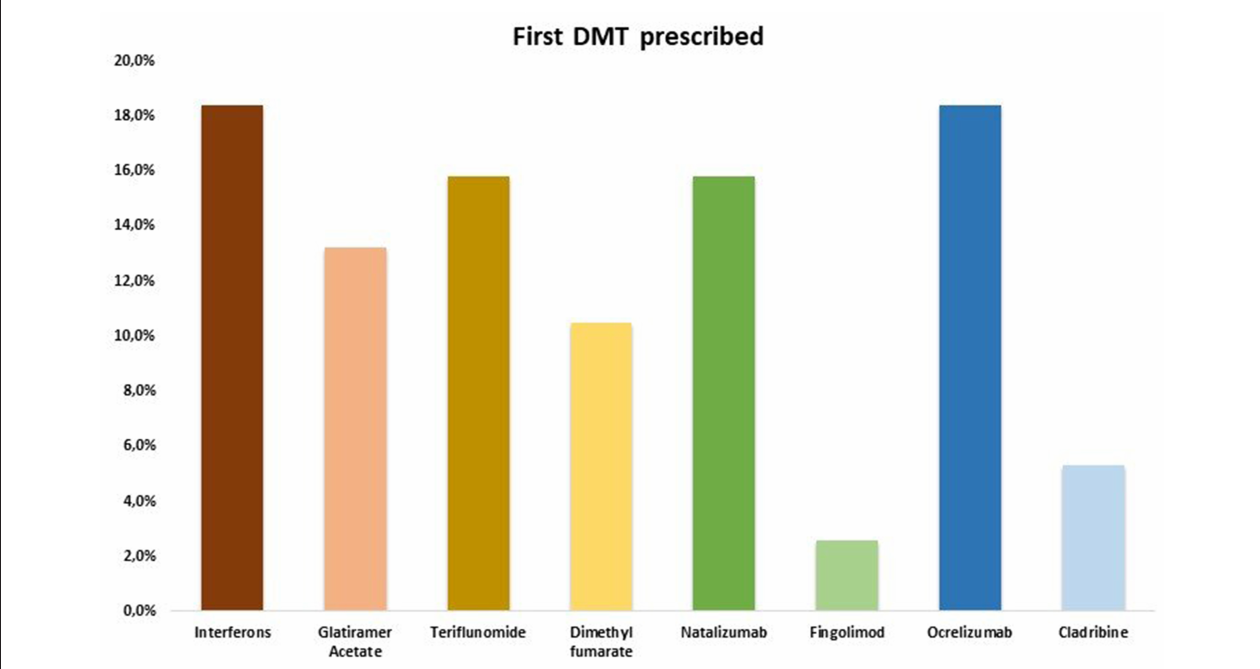
FIGURE 2 | First DMT prescribed. DMT, disease modifying